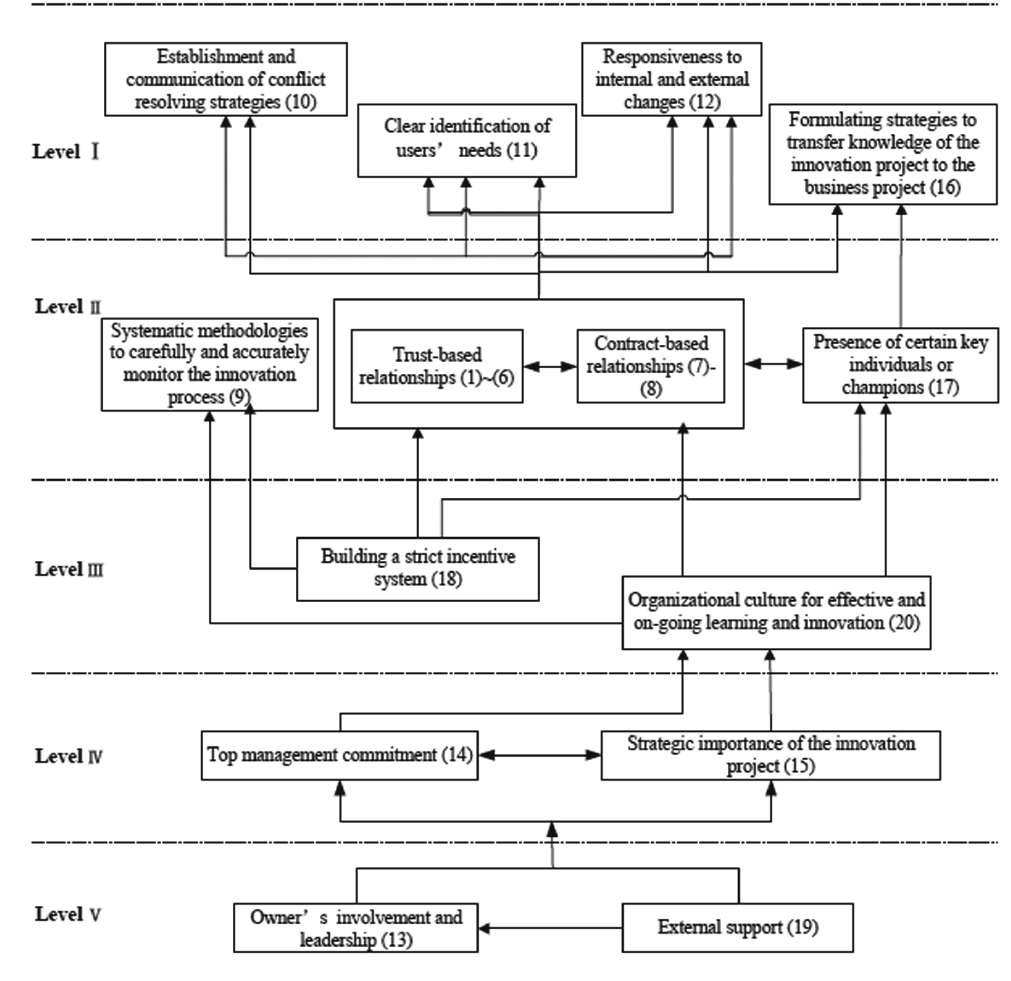
Fig. 2. Diagraph of CSFs for innovation in China’s construction